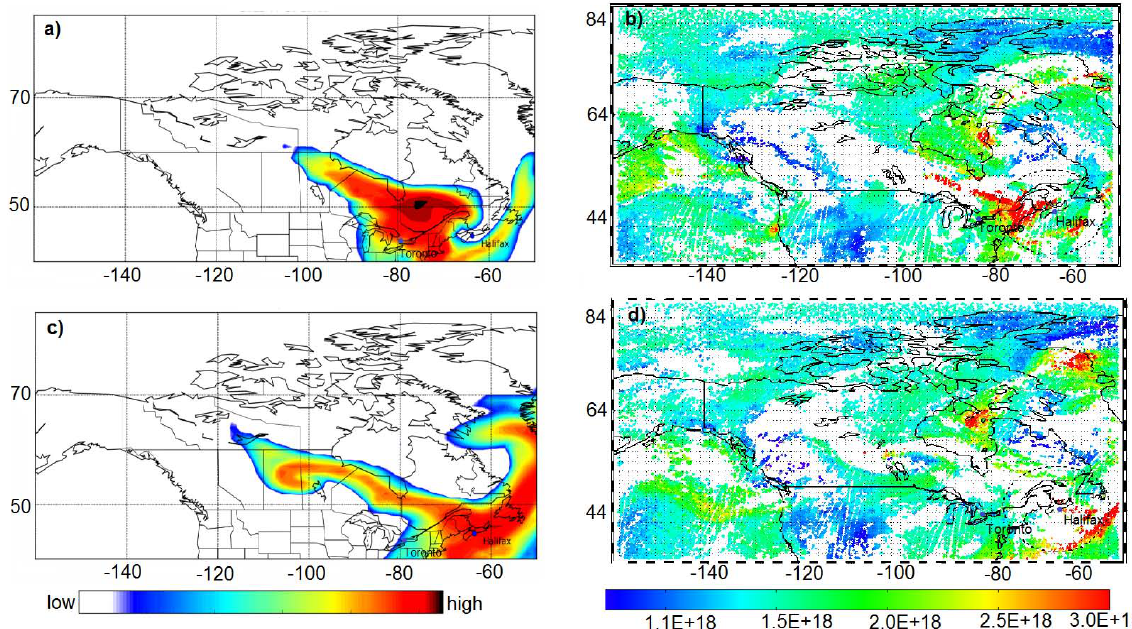
Fig. 6. FLEXPART forward trajectories at 15:00UTC on (a) 20 July and (c) 21 July 2011, for a constant particle release starting on 17 July 2011 at 12:00UTC. The colour contours are on a relative scale from high (red) to low (blue) low concentrations. IASI CO total columns in moleccm − 2 on (b) 20 July and (d) 21 July 2011 for the morning overpass (approximately